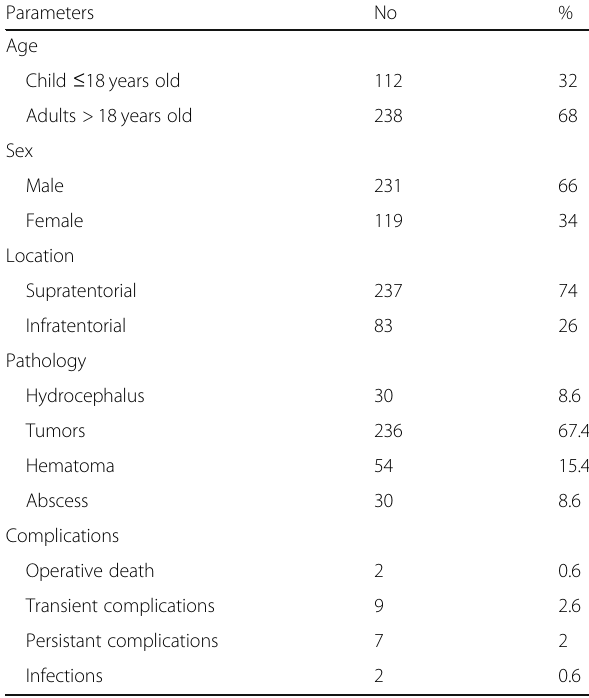
Table 1 Patients and brain lesions